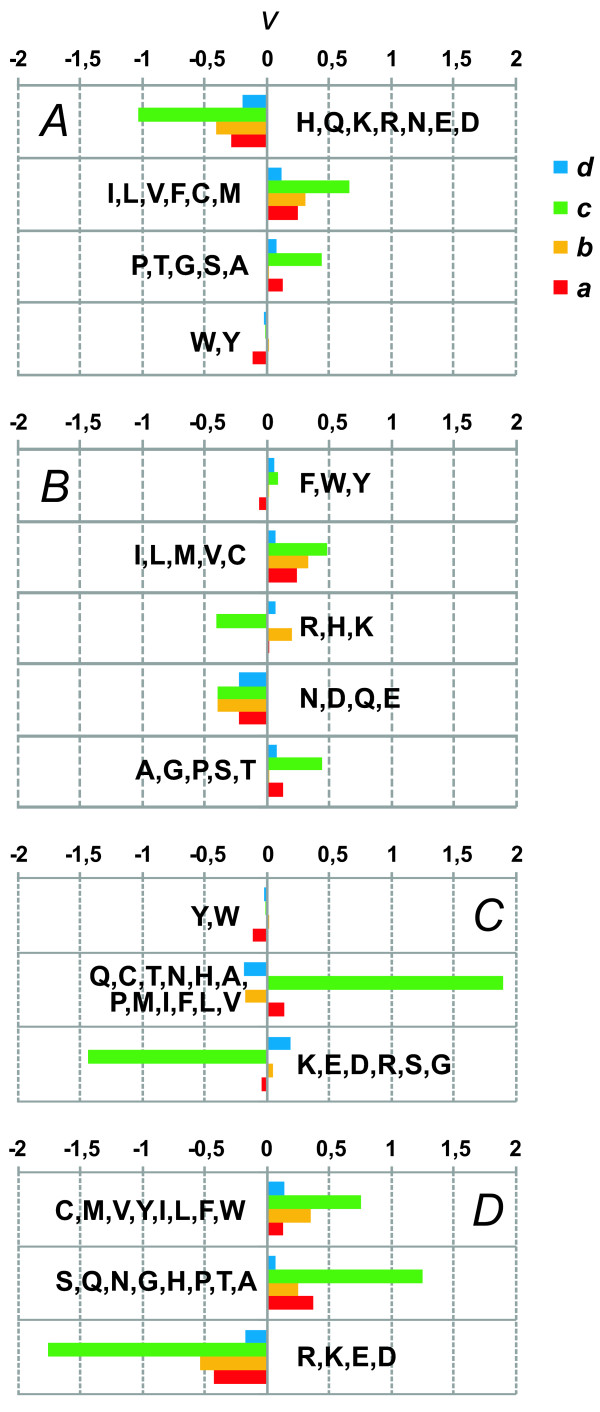
The values of the ν parameter reflecting changes in amino acid frequencies for different evolutionary tree branches for categorizations based on the physico-chemical properties combinations. Designations are as in Figure 4. Combination: A, polarity and hydropathy; B, polarity and volume; C, hydrophilicity and pressure asymmetry index; D, polarity and hydrophilicity.